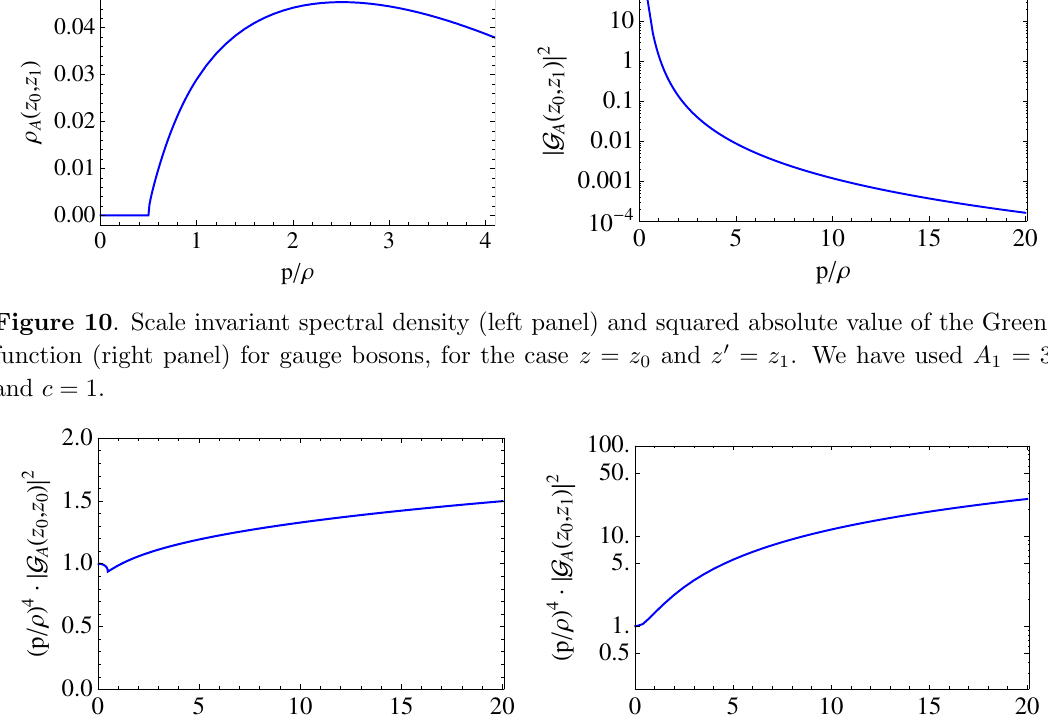
Figure 11 . Left (right) panel is (cid:27) ( q (cid:22) q ! g (cid:3) ! Q (cid:22) Q ) =(cid:27) SM ( q (cid:22) q ! g 0 ! Q (cid:22) Q ), versus p=(cid:26) , with p (cid:17) being the partonic energy, while Q is a light (heavy) quark living on the UV (IR) brane. We have used A 1 = 35 and c =